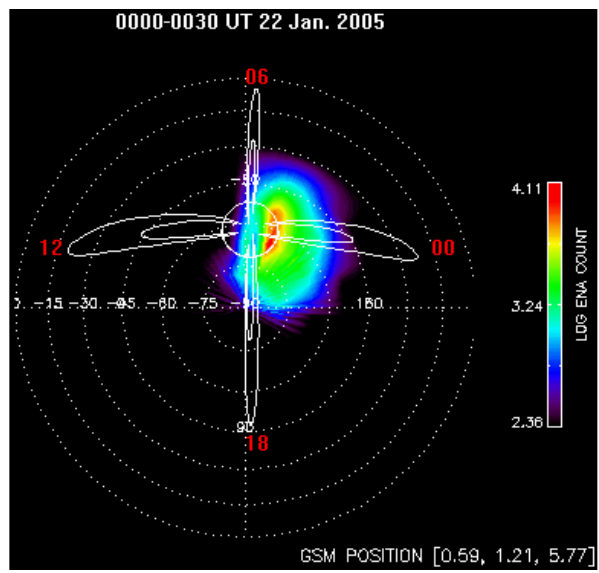
Fig. 11. The final recovered ENA image displayed in the same for- Figure 11. mat used in the left panel of Fig.